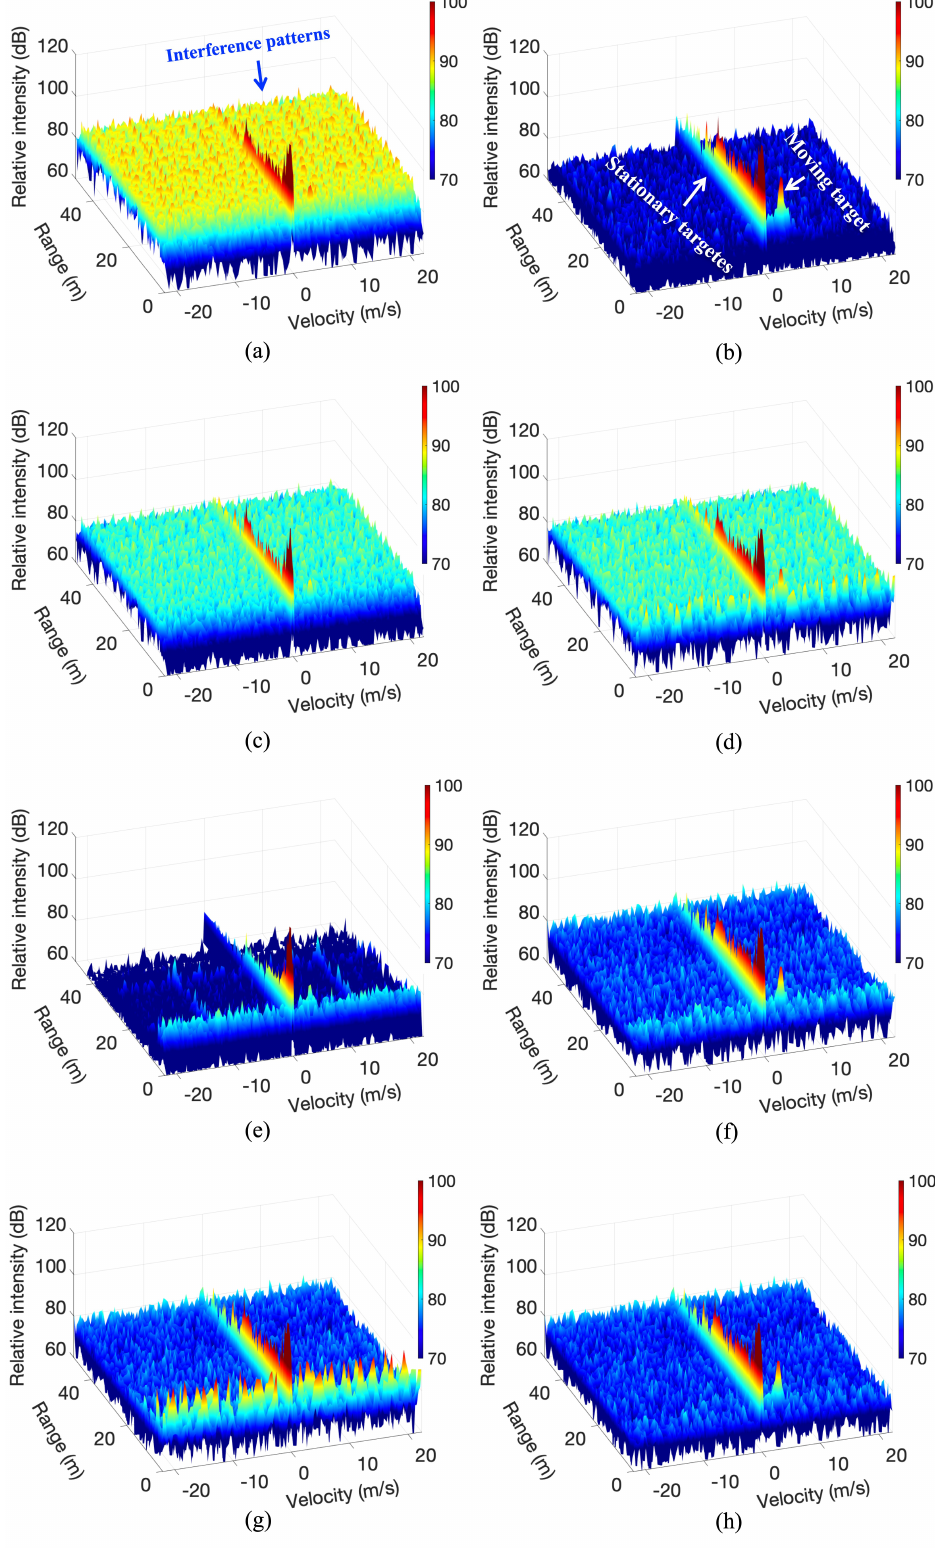
Figure 11. Comparisons using real radar data. ( a ) Original image; ( b ) Interference-free image; ( c ) Lee et al. [19]; ( d ) Lee et al. [19] + Proposed interference detection; ( e ) Uysal [23]; ( f ) Uysal [23] + Proposed interference detection; ( g ) Brooker [15]; and ( h ) The proposed